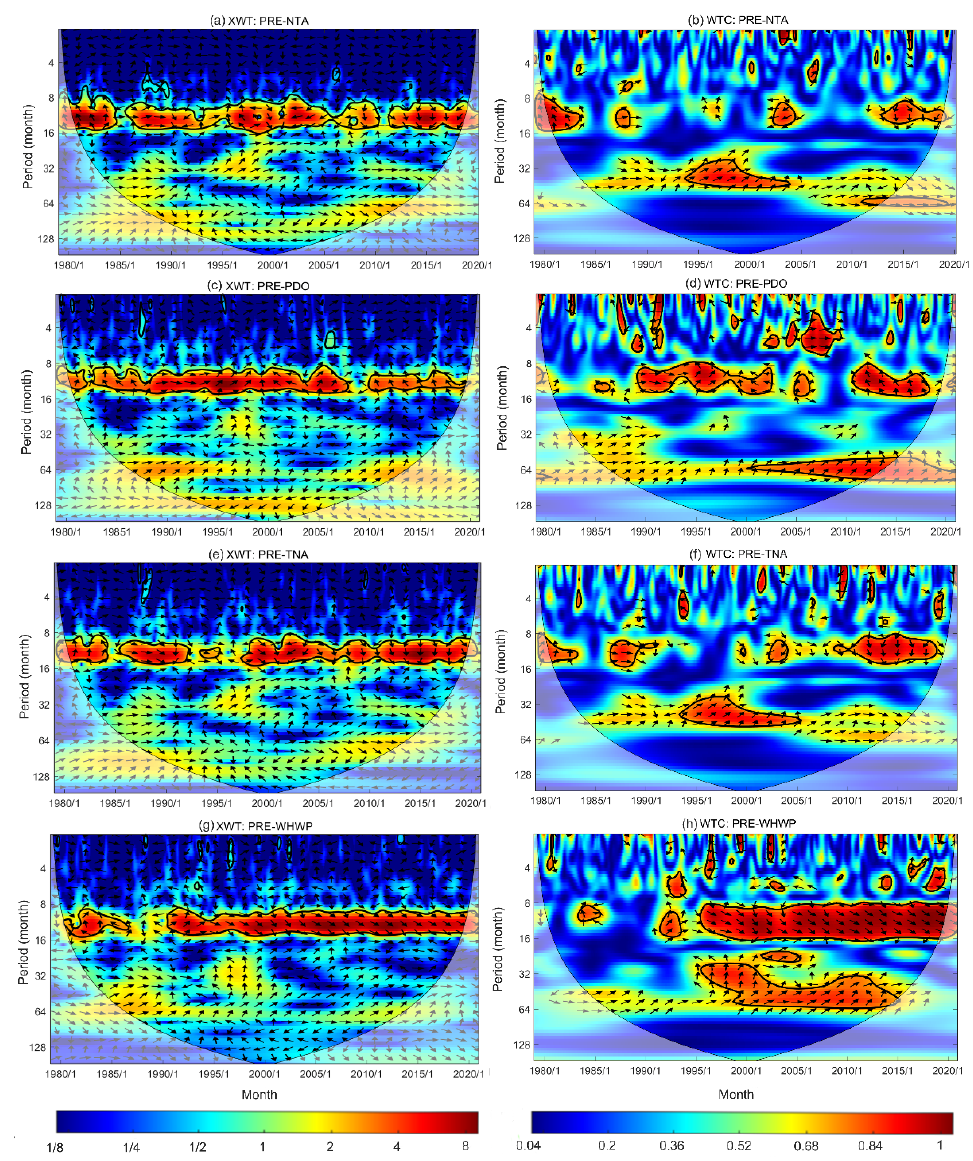
Figure 11. Cross-wavelet and wavelet correlations between precipitation and NTA, PDO, TNA, WHWP: ( a , c , e , g ) are cross-wavelet analyses between precipitation and NTA, PDO, TNA, and WHWP, respectively. ( b , d , f , h ) are wavelet correlations between precipitation and NTA, PDO, TNA, and WHWP, respectively.